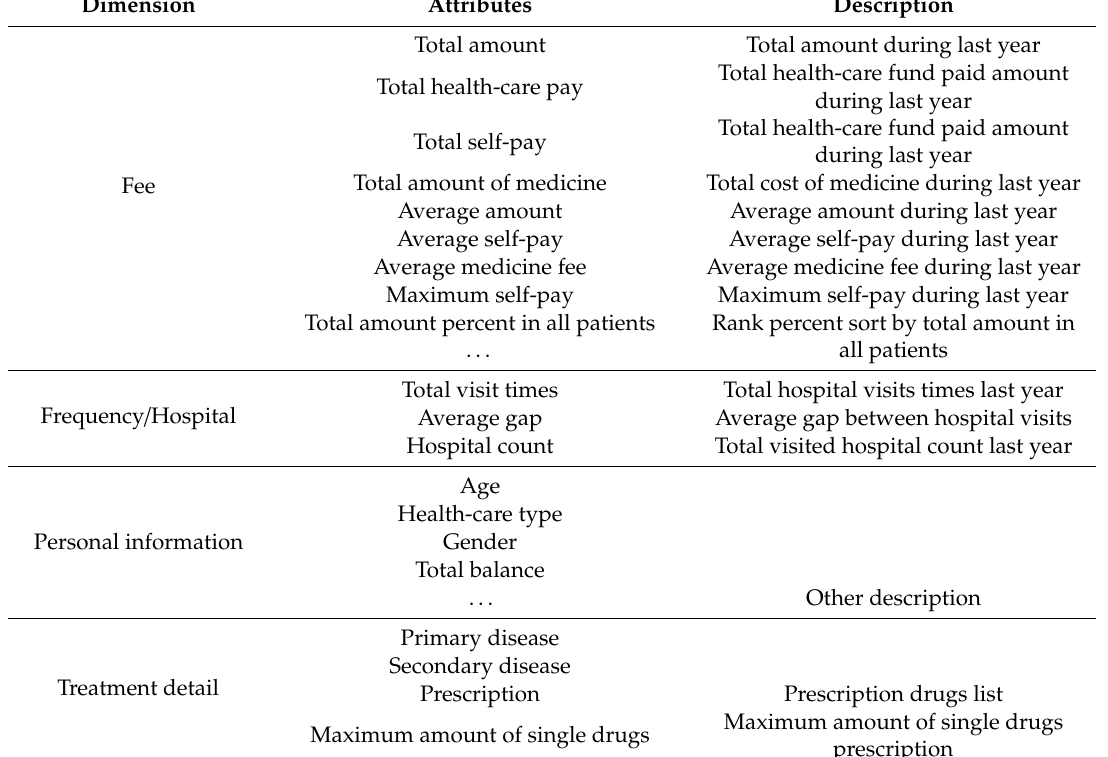
Table 2. In order to get better result during outlier detection, we filtered the features into 20 features depending on mutual information base on 1000 manual labeled records. Table 2. Main